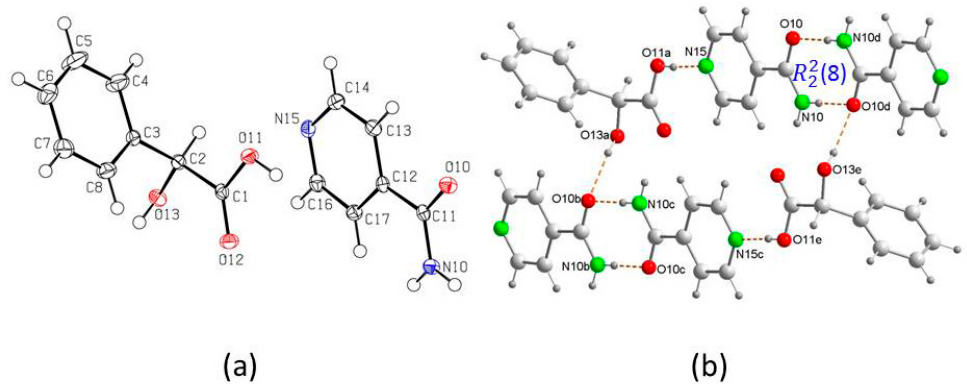
Figure 3. ( a ) Asymmetric unit of inam - L-H 2 ma - and ( b ) four-membered supramolecular unit in the crystal structure of inam - L-H 2 ma (1:1) co-crystal.